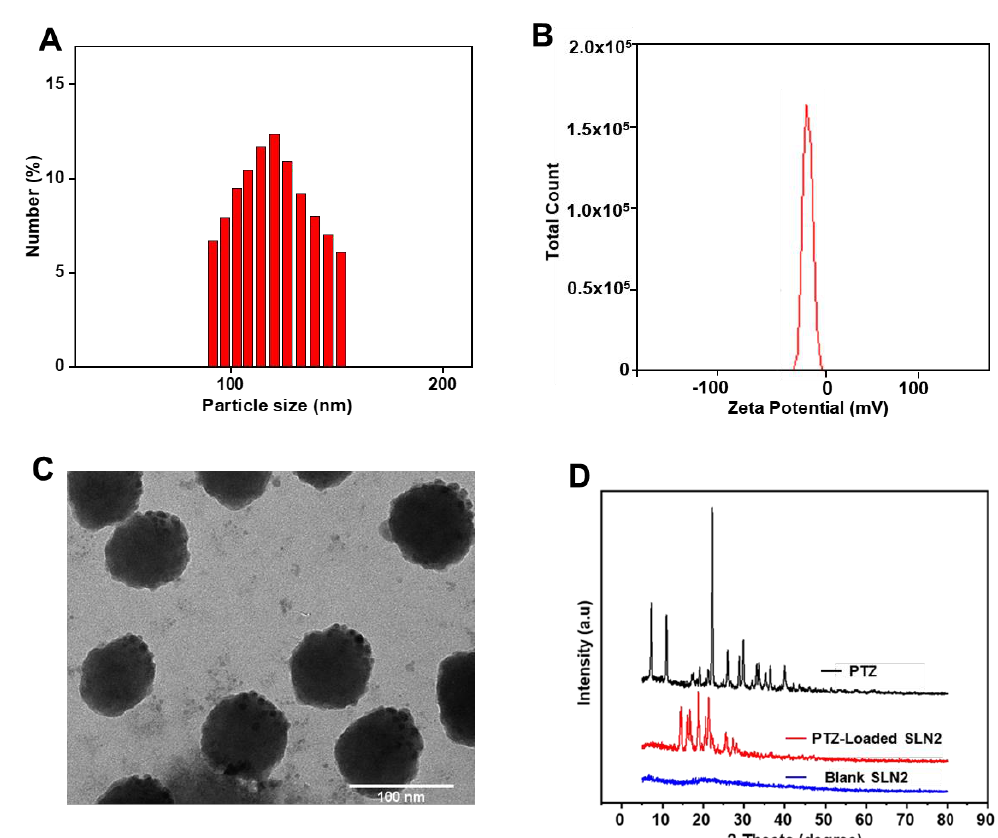
Figure 1. ( A ) Hydrodynamic diameter of optimized SLN s formulation (SLN2) by DLS; ( B ) ZP of SLN2 formulation; ( C ) TEM micrograph of the SLN2 formulation. Scale bar is mentioned; ( D ) XRD spectrum of free PTZ (drug), blank SLNs (unloaded), and PTZ-loaded SLN2.